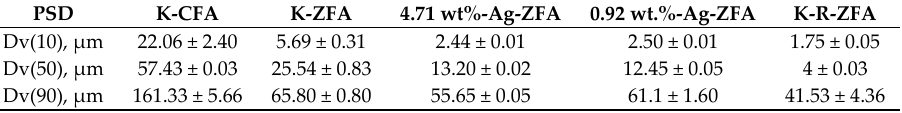
Table 3. PSD analysis of materials.